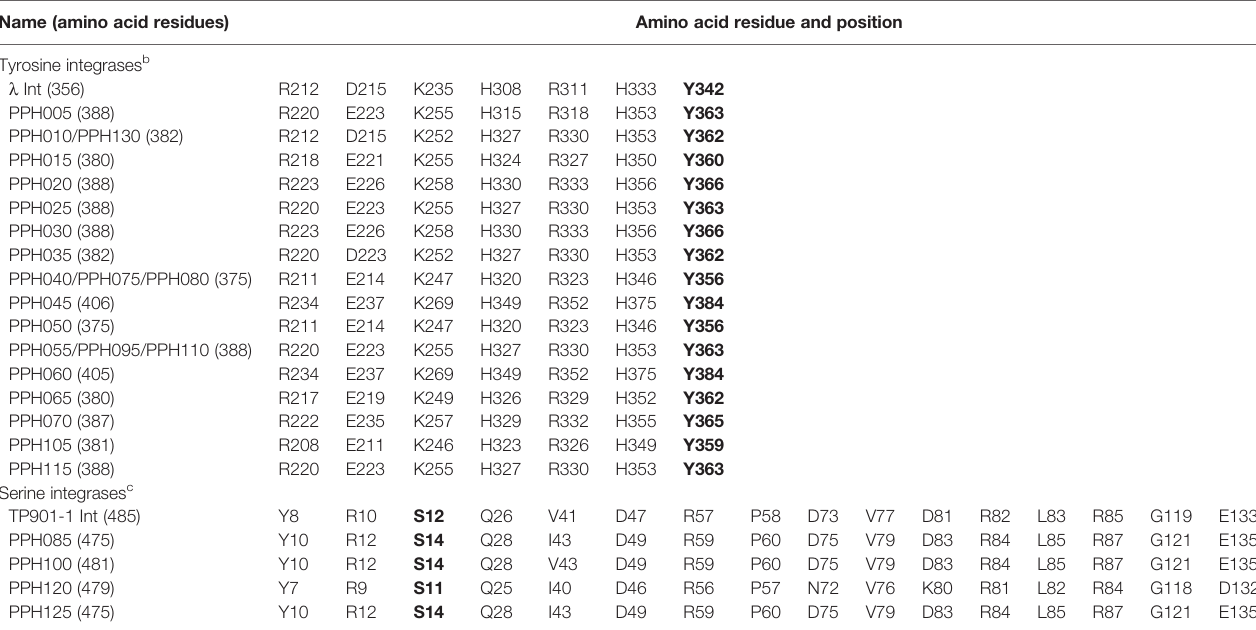
TABLE 2 | Active site residues of PPH tyrosine and serine recombinases a